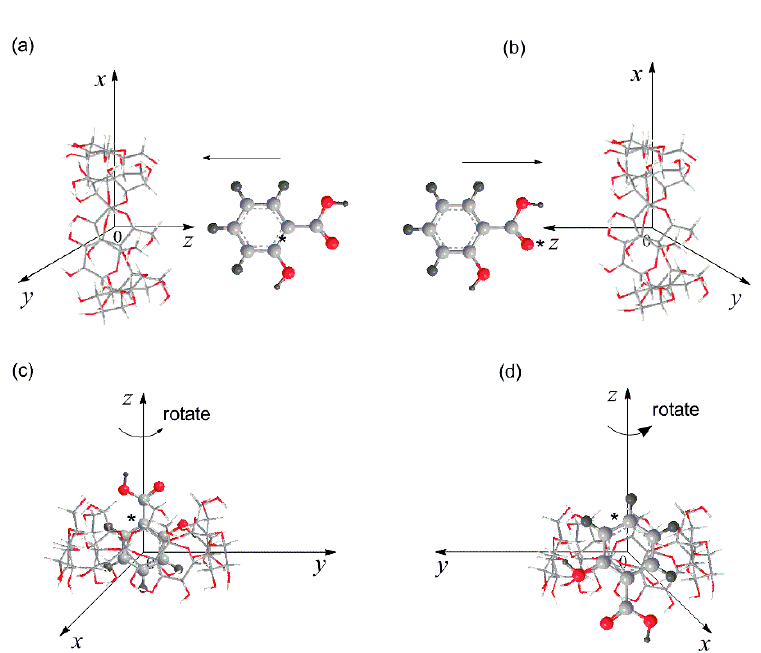
Figure 9. Coordinate systems used to define the complex processes: passing process for ( a ) head-up and ( b ) head-down orientations; circling process of ( c ) head-up and ( d ) head-down orientations. The labeled carbon atom (C*) of the guest molecule is used to express the relative position between the guest and host when the guest passes through the cavity of the β -CD.